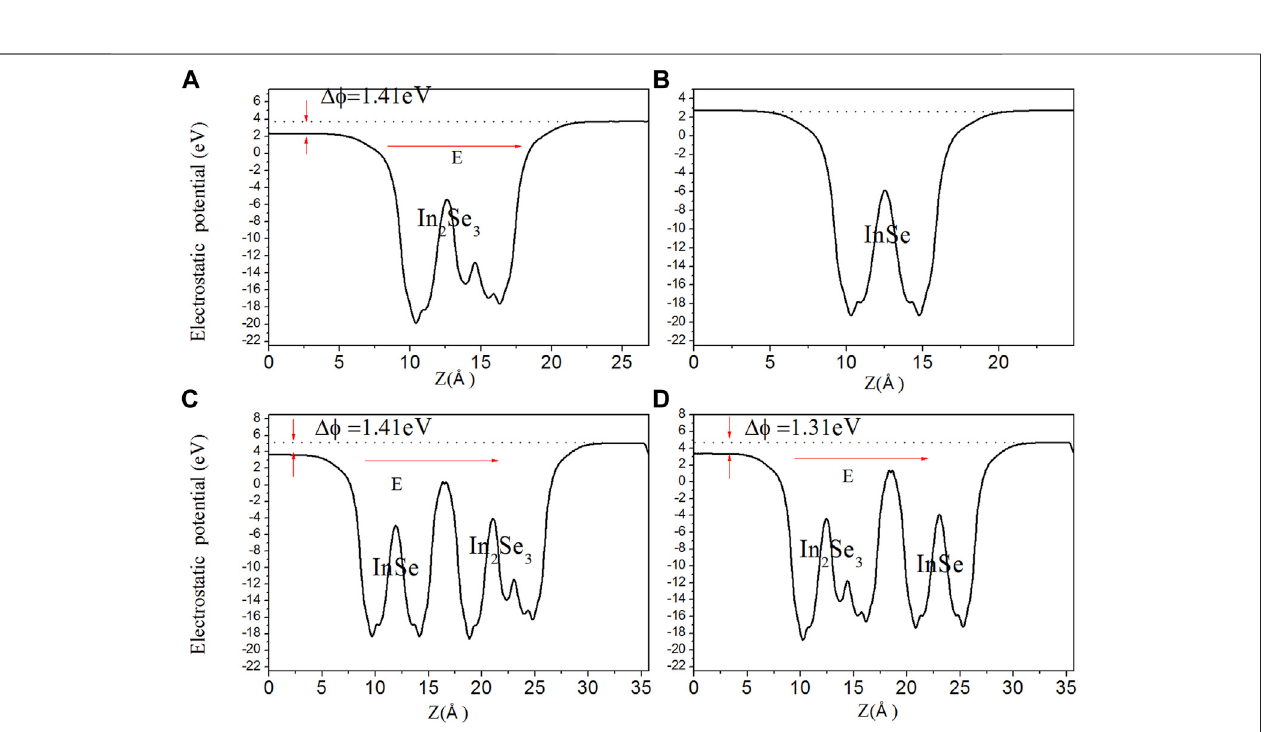
FIGURE4| Electrostaticpotentialsof (A) monolayerIn 2 Se 3 , (B) monolayerInSe,and (C) In 2 Se 3 /InSe(up)and (D) In 2 Se 3 /InSe(down)heterostructures.Thedotted lines and the red arrows represent the vacuum level and the direction of the built-in electric fi eld, respectively.